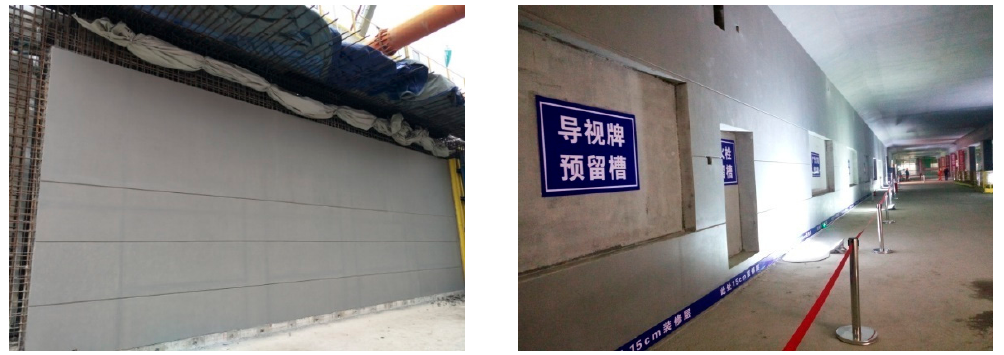
Figure 1. Architectural concrete applied in Qingdao subway